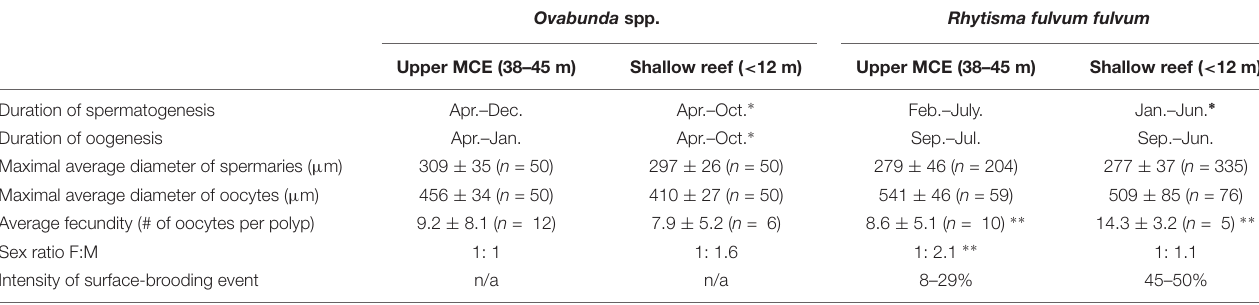
TABLE 1 | Ovabunda spp. and Rhytisma fulvum fulvum : Comparison of reproductive features between the upper MCE and shallow reef (n indicates sample size). Ovabunda spp.